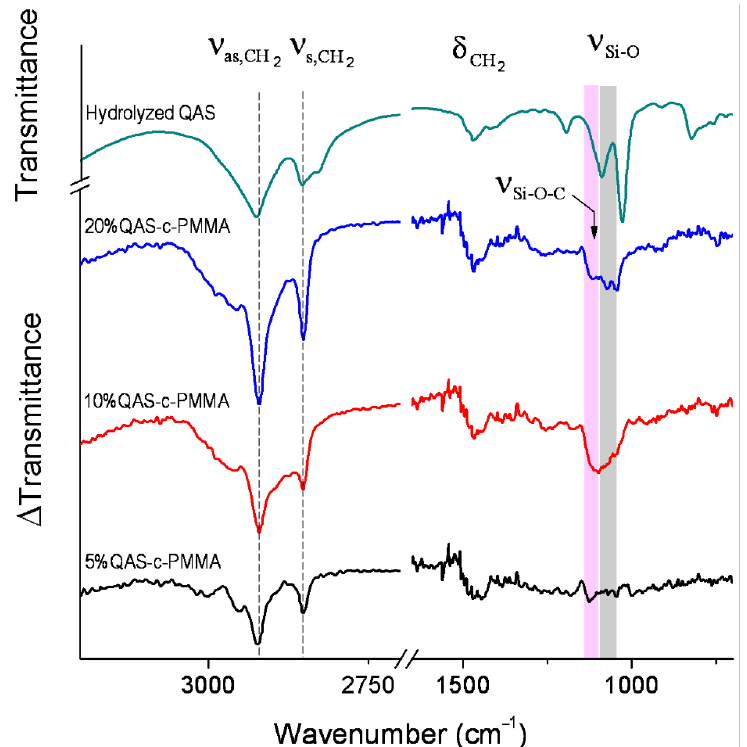
Figure 1. Fourier transform infrared (FTIR) difference spectra (relative to the acid-treated polymethyl methacrylate (PMMA), using the absorbance of the peak at 1721 cm − 1 as a reference), examined using attenuated total reflectance, of the QAS-c-PMMA samples prepared in 5%, 10%, and 20% quaternary ammonium salts (QAS) solutions, and the FTIR spectrum of the hydrolyzed QAS, measured in transmission mode. All spectra were obtained at a 4 cm − 1 resolution. The bands at 2826 and 1027 cm − 1